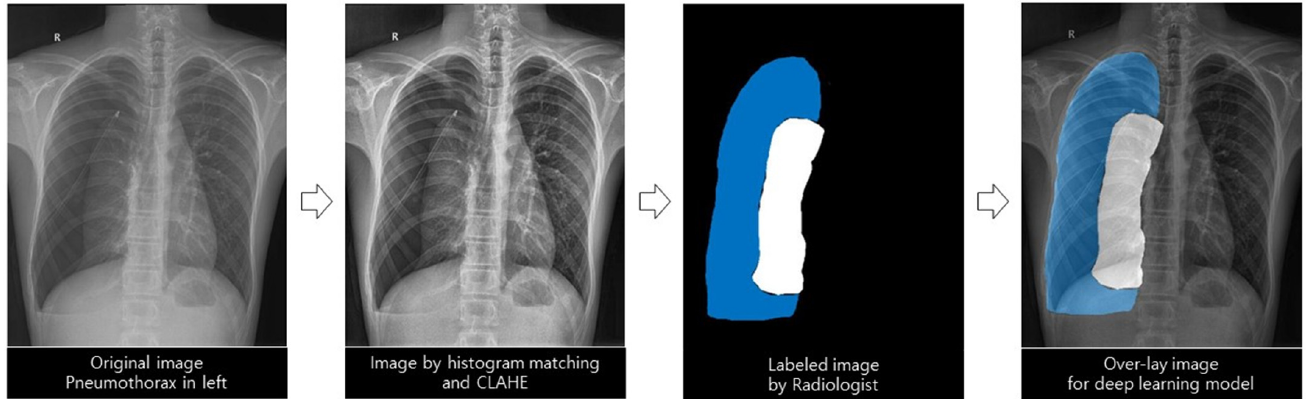
Figure 2. Deep learning model for automatic differentiation and segmentation of